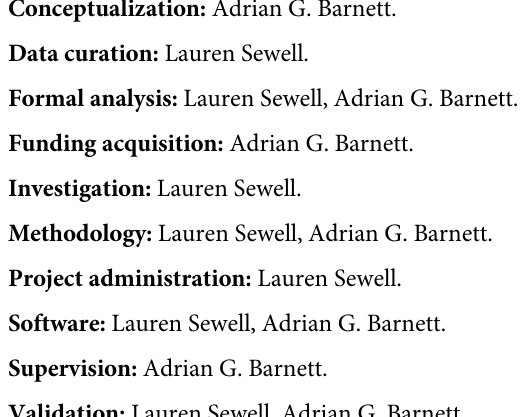
S1 Fig. Flow diagram of participant